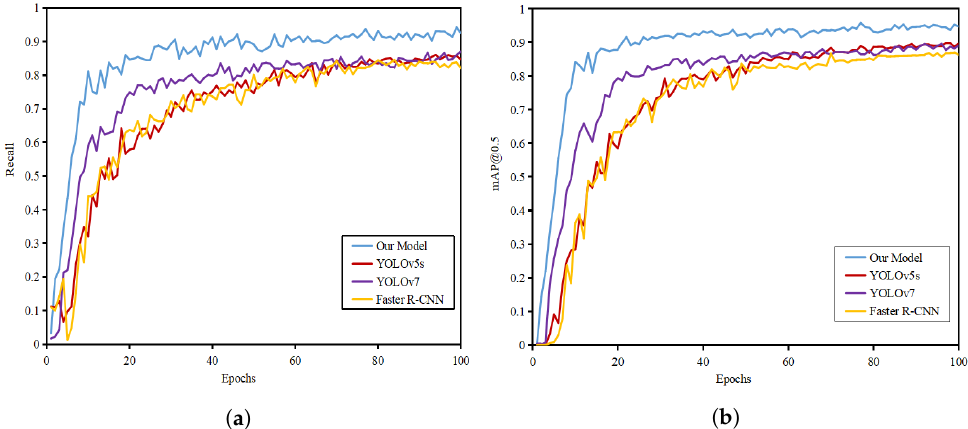
Figure 13. Comparison of training results of different models: ( a ) recall curve; ( b ) mAP@0.5